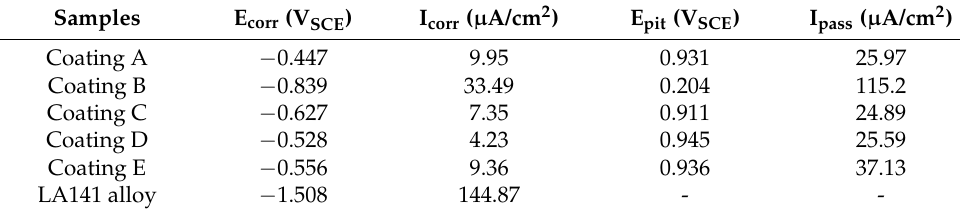
Figure 5. ( a ) Potentiodynamic polarization curves of Fe-based AMCs and LA141 magnesium alloy; ( b ) potentiostatic polarization curves of Fe-based AMCs. Table 2. Corrosion data determined from the potentiodynamic polarization curves.